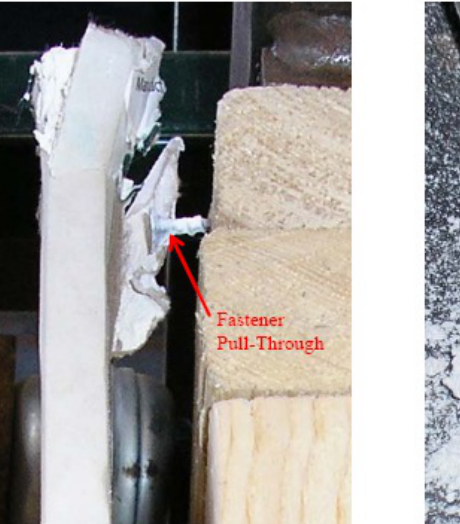
Figure 17. Typical Damage to Gypsum Wallboard Corners.